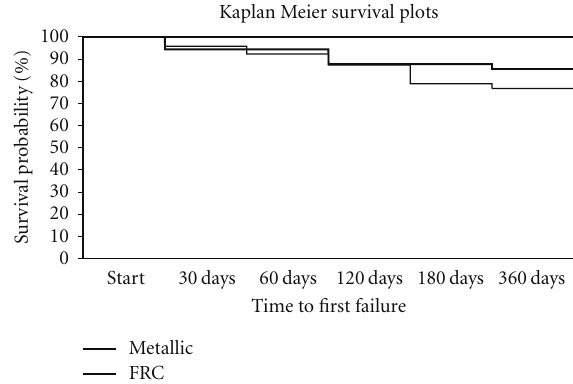
Figure 2: Survival plots for multistrand wire and FRC